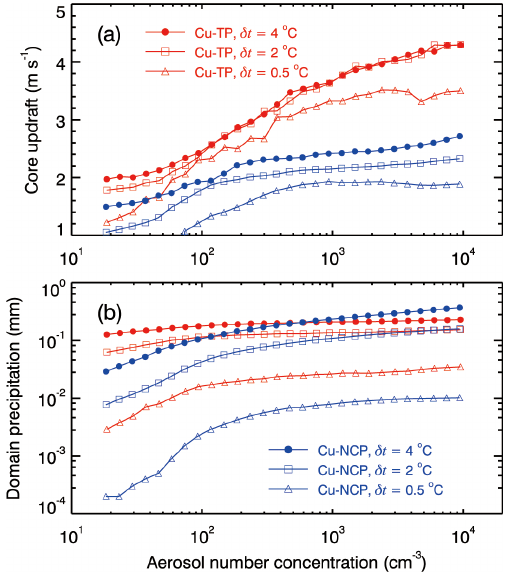
Figure 8. Response of (a) the p mean of core updraft and (b) cu- mulative precipitation inside the model domain to the change in the maximum perturbation temperature of the warm bubble under vari- ous aerosol conditions in Cu-TP and